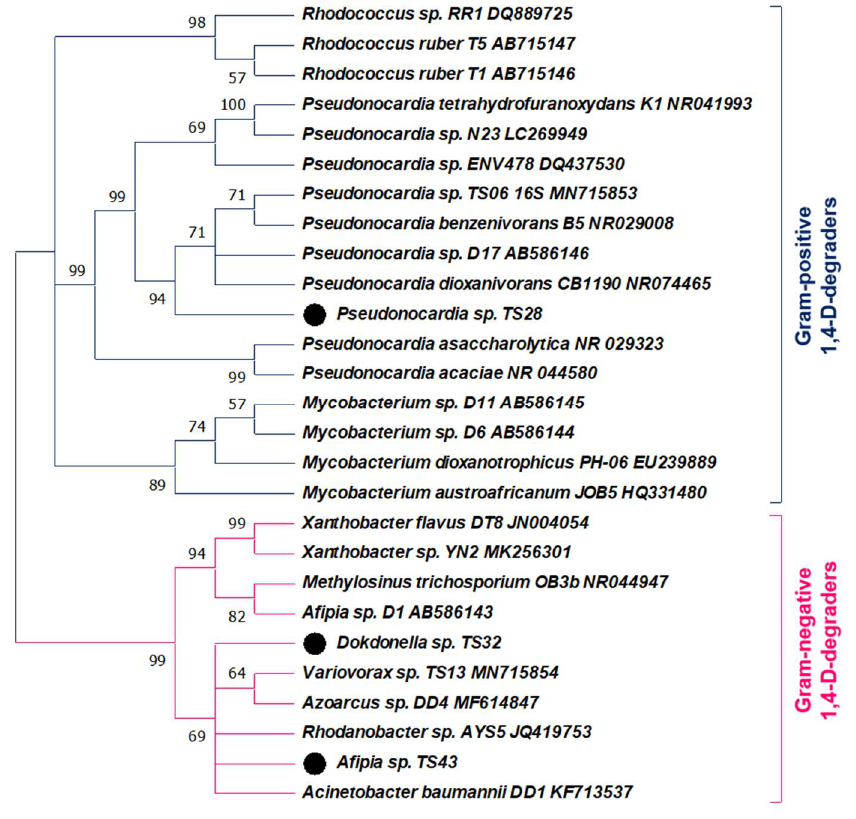
Figure 2. Neighbor-joining tree depicting phylogenetic relationships among 1,4-D-degrading strains isolated in this study (indicated by the black circles) and previously reported Gram-positive and Gram-negative 1,4-D-degraders. The nucleotide sequences of 16S rRNA genes were used to construct the phylogenetic tree, whereas the numbers at the branching points are the bootstrap values of 1000